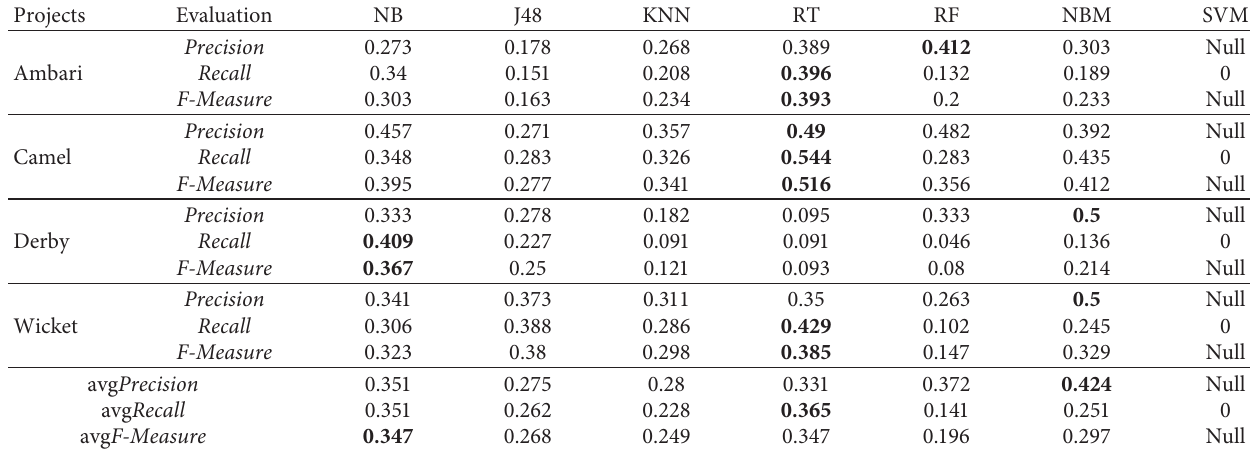
Table 5: The performance of seven classification